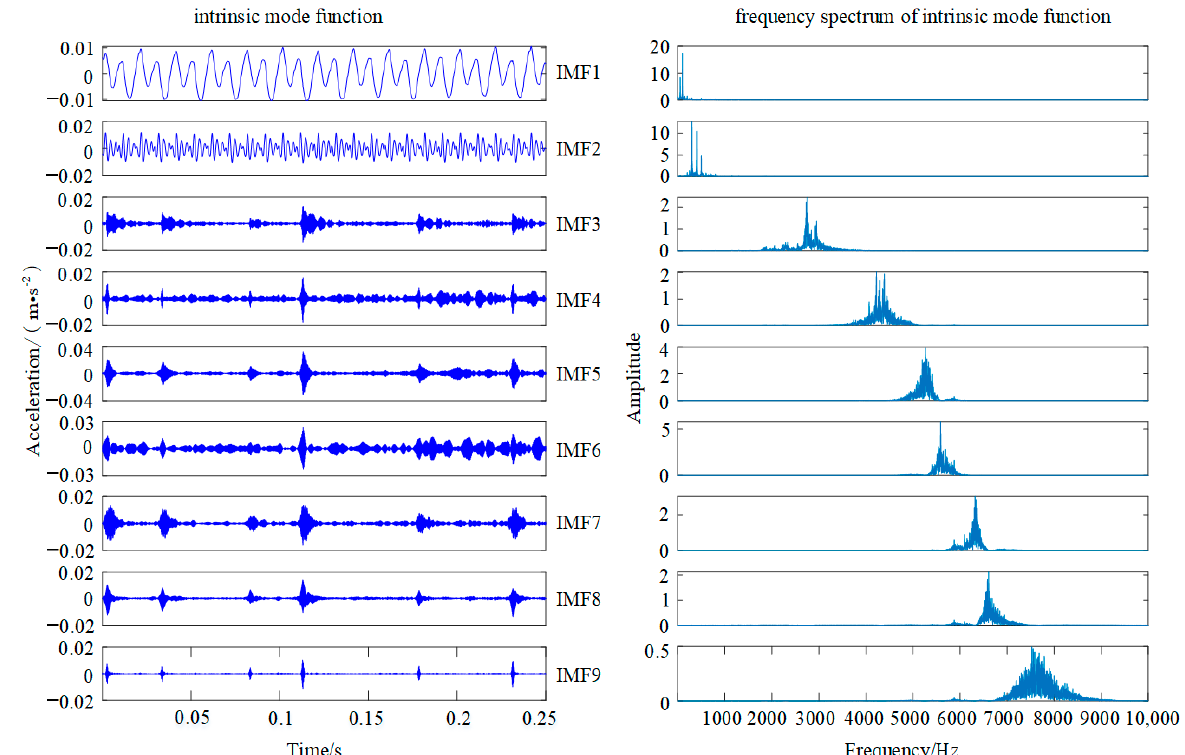
Figure 8. APA-PSO-VMD decomposition diagram.